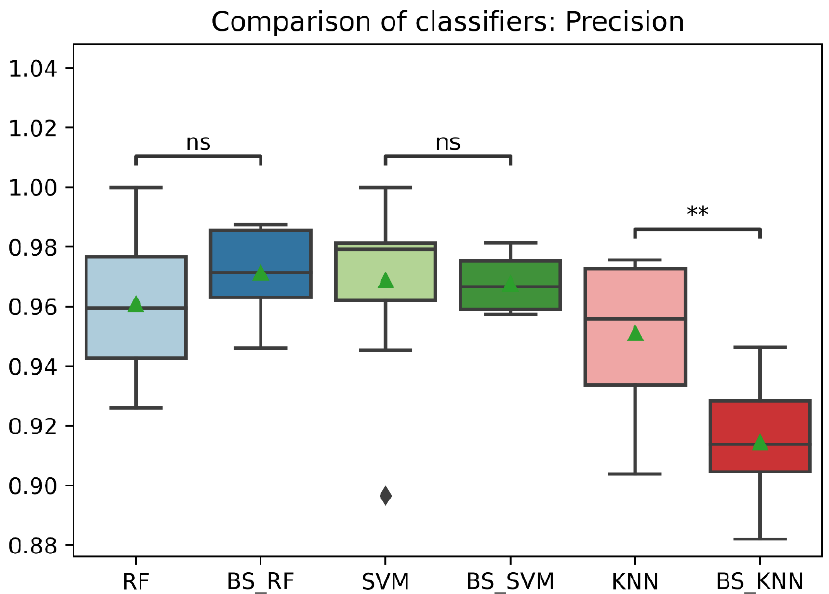
Figure 8. Comparison of precision between classification models with imbalanced and oversampled data. RF = Random Forest; BS_RF = Borderline-SMOTE in Random Forest; SVM = Support Vector Machine; BS_SVM = Borderline-SMOTE in Support Vector Machine; KNN = K-nearest Neighbors; BS_ KNN = Borderline-SMOTE in K-nearest Neighbors; ns: p > 0.05; **: p ≤ 0.01.